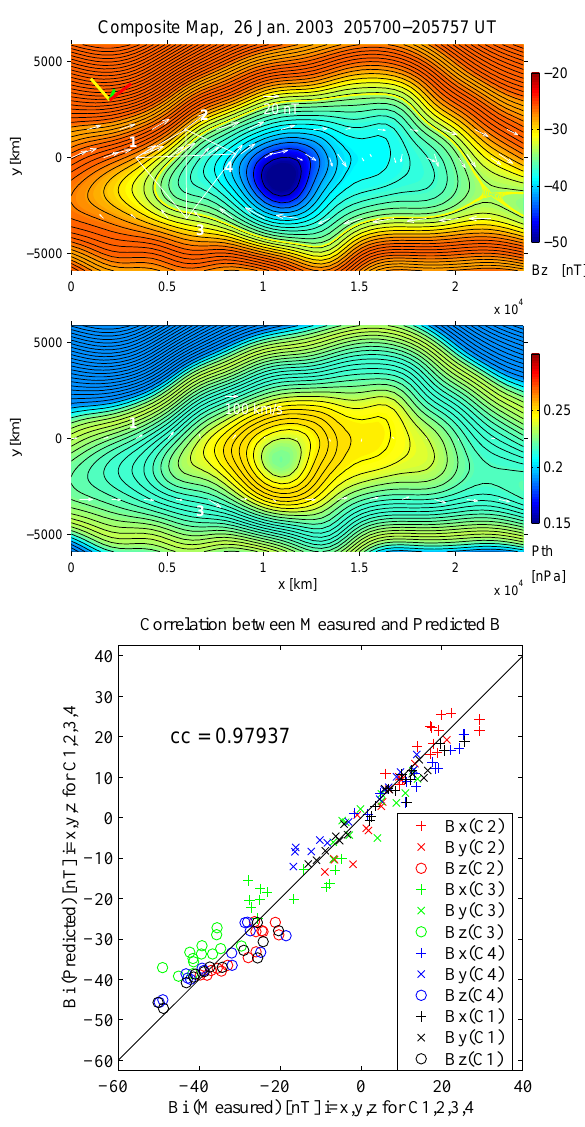
Fig. 8. Field and pressure maps and associated scatter plot for FTE